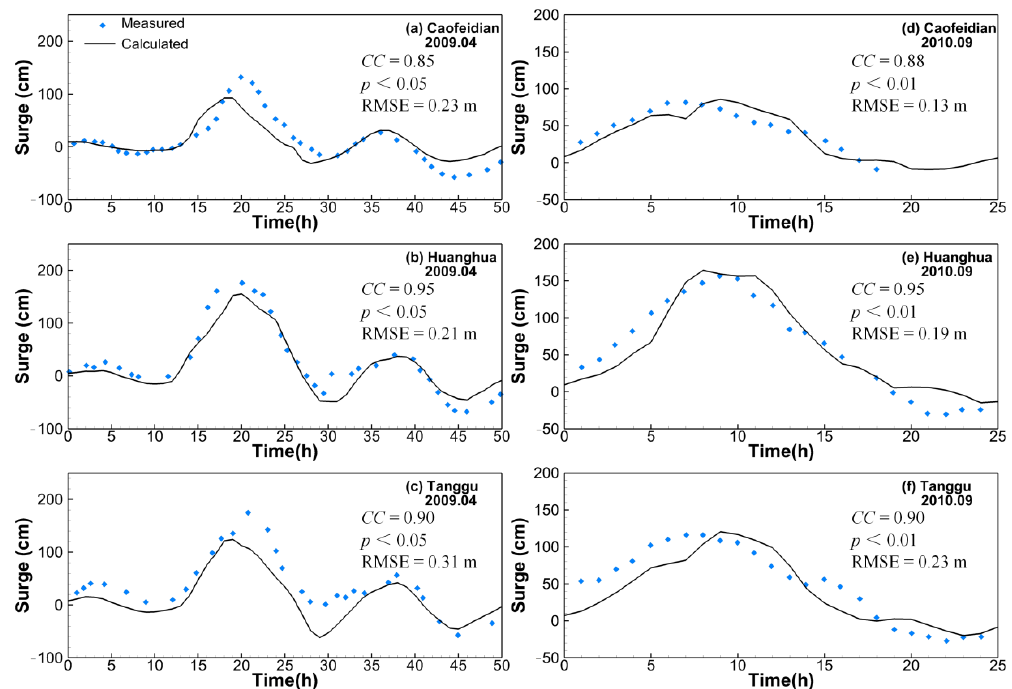
Figure 4. Comparison between the wave parameters output from the 1st iteration (run 5, blue dots) and the 2nd iteration (run 7, black line). ( a ) Significant wave height ( H s ) at W1. ( b ) Significant wave period ( T ) at W1. ( c ) Significant wave height at W2. ( d ) Significant wave period at W2.